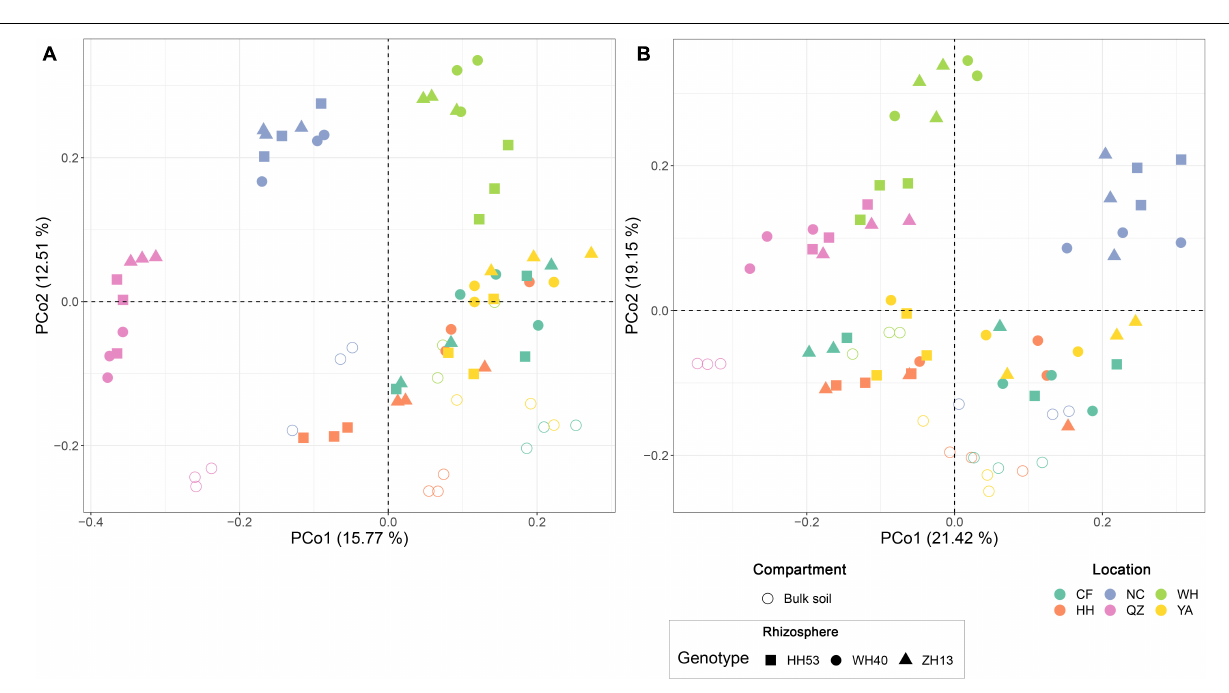
FIGURE 3 | Principal coordinate analysis based on Bray-Curtis (A) and weighted UniFrac (B) distances the showing contribution of compartment, location, and cultivar on shaping the overall composition of root-associated protist communities of soybean fields in